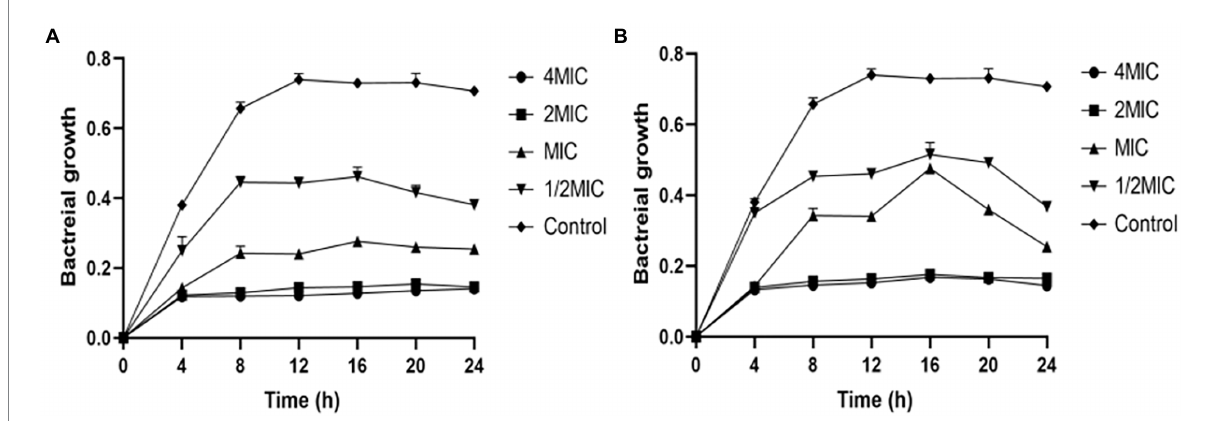
FIGURE 3 E. faecium E3101 growth inhibition curves. The curves showing the effect of ZJ-2 (A) and linezolid (B) on the growth of E. faecium E3101. Each OD point presented is the average values of three tests and all experiments are internally.